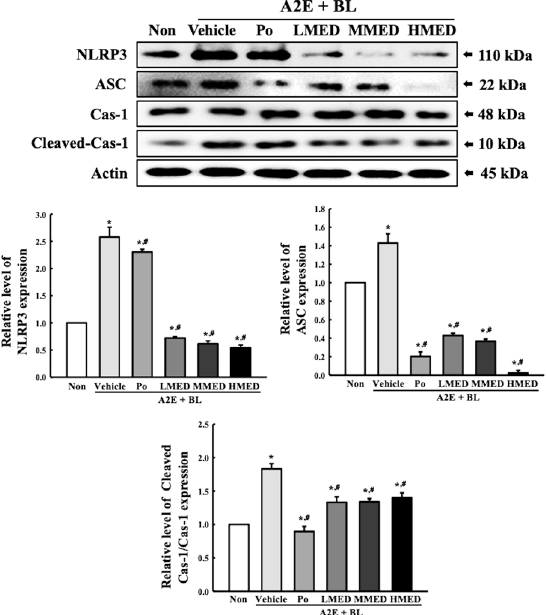
Figure 9. Expression of inflammasome in MED + A2E + BL treated ARPE19 cells. After treatment with MED for 24 h, the expression level of key regulators in inflammasome, including NLRP3, ASC, Cas-1, Cleaved Cas-1 and actin were measured in total cell lysates using Western blot analysis. The total proteins homogenates were prepared from two to three samples per group, and Western blot analyses for each sample was analyzed in duplicate. All values in results are represented as the means ± standard deviation (SD). * indicated statically significance compared to the Non treated group, while # indicated statically significance compared to the Vehicle + A2E + BL treated group. Abbreviations: NLRP3, NLR family pyrin domain containing 3; ASC, Apoptosis-associated speck-like protein; Cas-1, Caspase-1; MED, methanol extracts of Dipterocarpus tuberculatus Roxb.; A2E: N-retinylidene-N-retinylethanolamine; BL, Blue light.